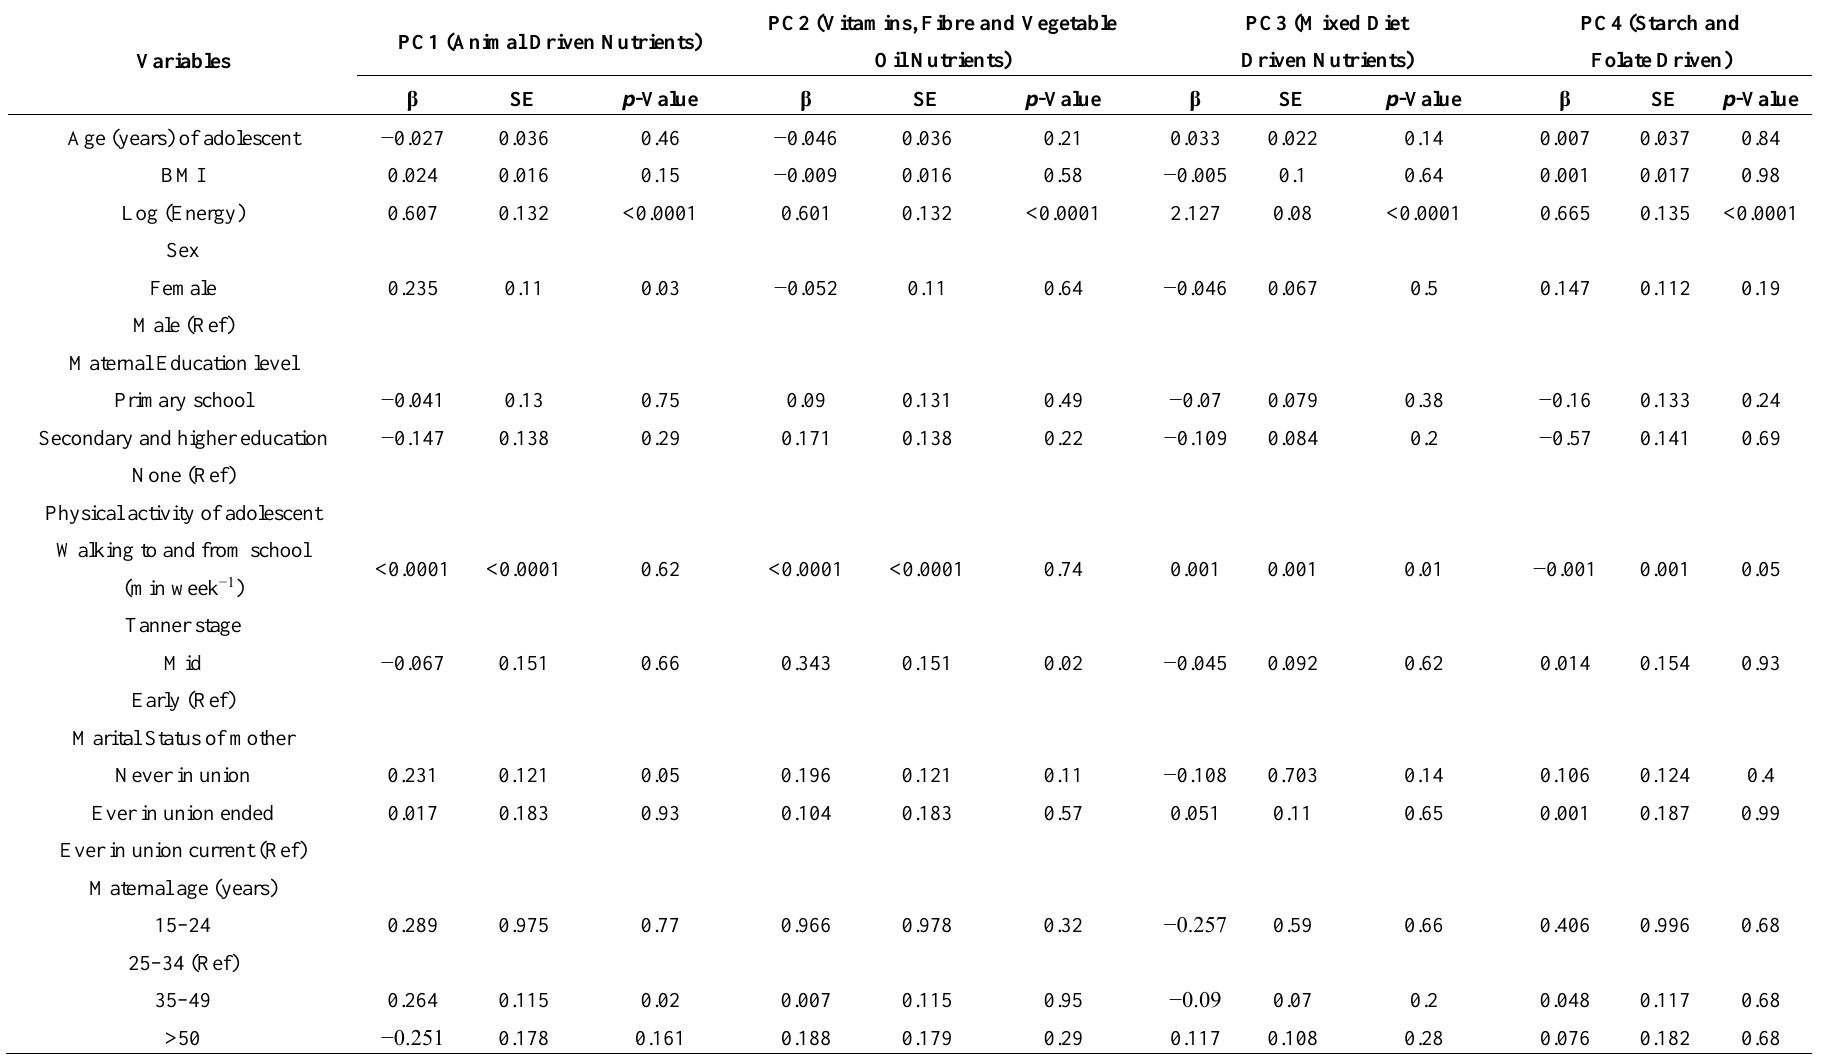
Table 2. Multiple regression derived coefficients (β) and standard errors (SE) of specified predictors for the four nutrient pattern scores.